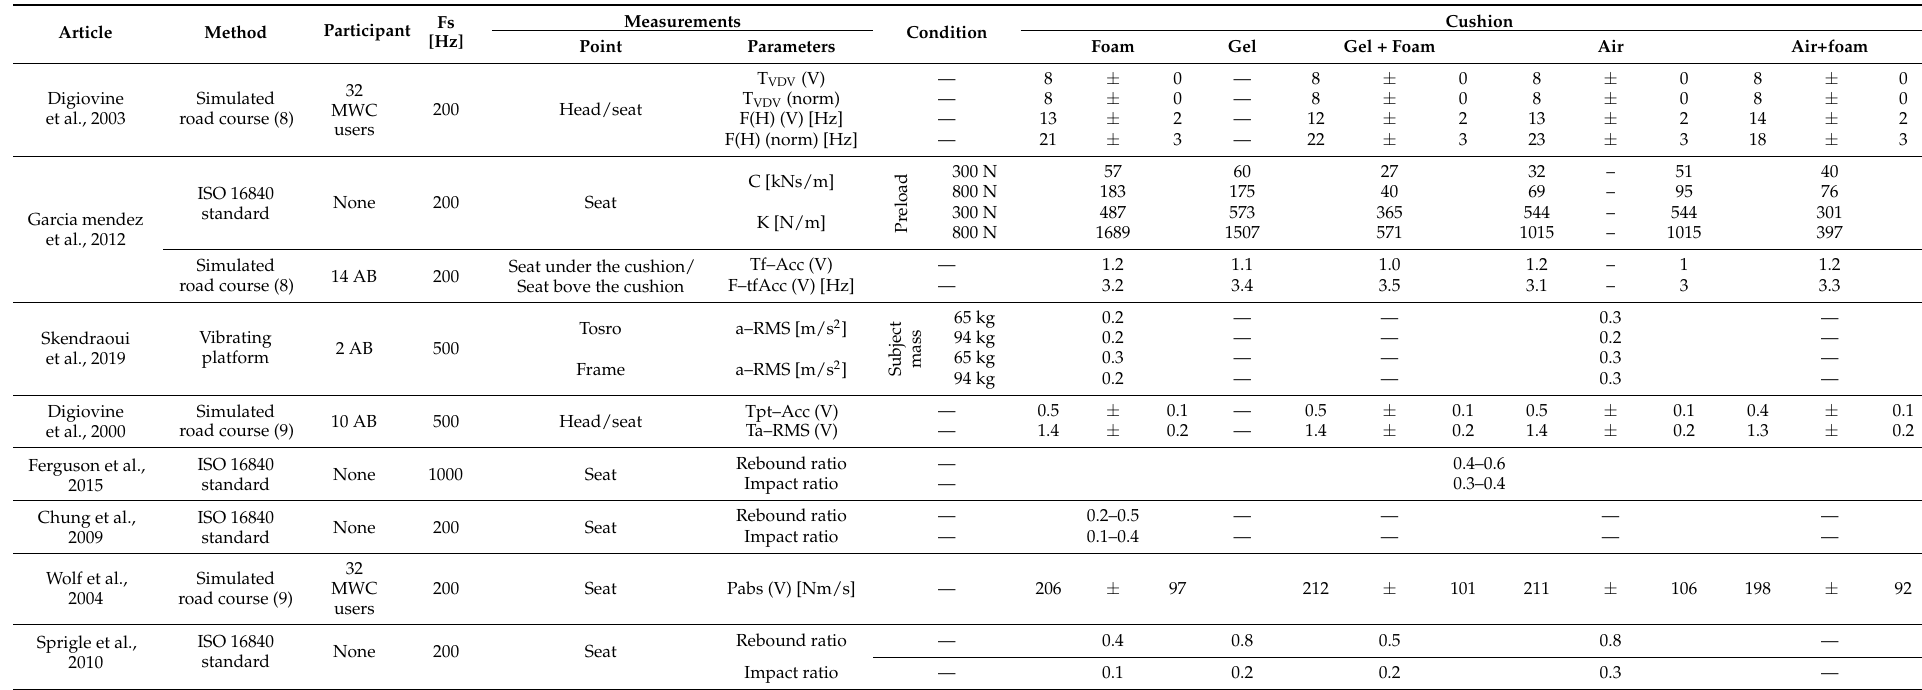
Table 9. Summary table of reviewed studies regarding the effects of cushion on vibration